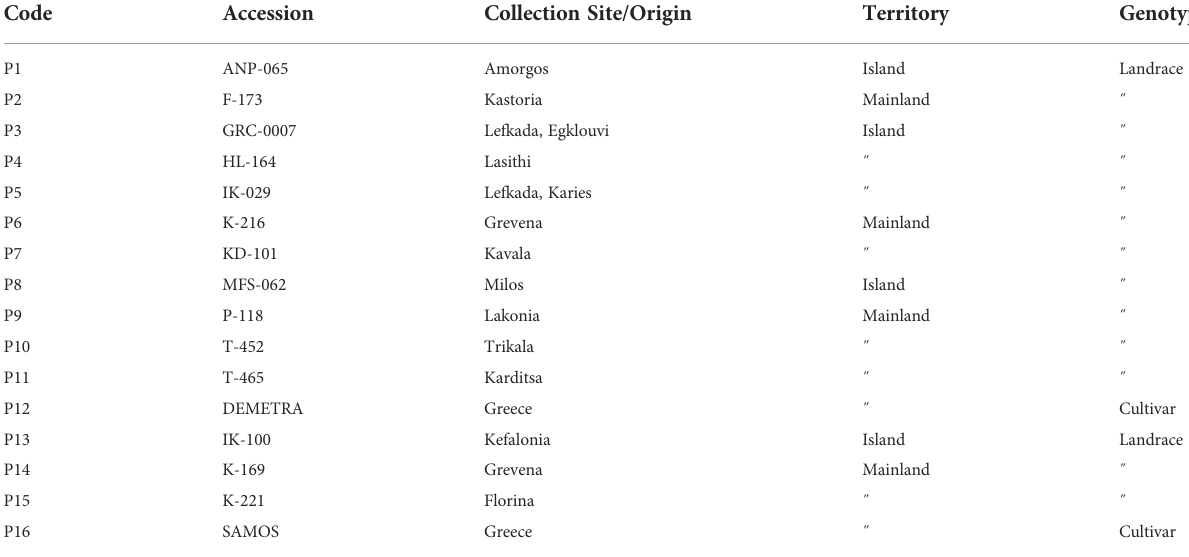
TABLE 1 Details on the collection sites and origin, genotype and sample source of the plant